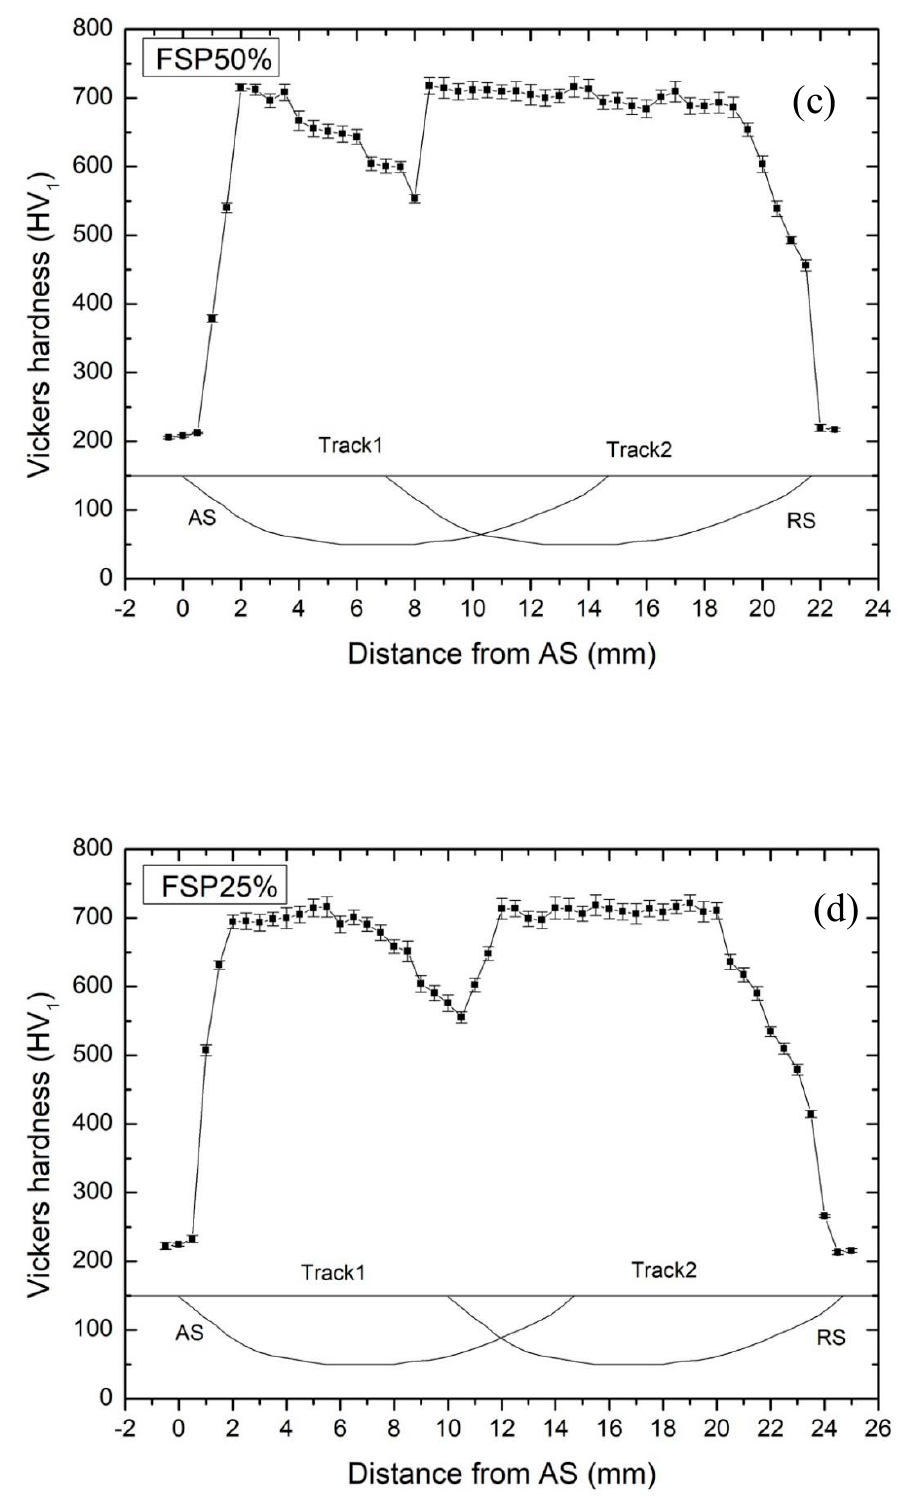
Figure 9. Hardness profiles of FSPed specimens at 0.2 mm below the surface in the longitudinal direction: ( a ) FSP250, ( b ) FSP75%, ( c ) FSP50%, and ( d ) FSP25%.